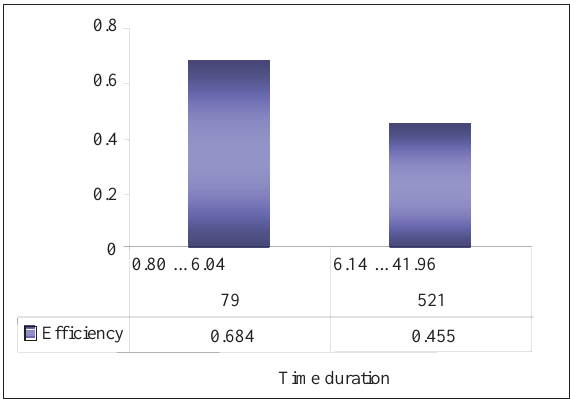
Figure 1. Th e relationship between type of off ense and scoring